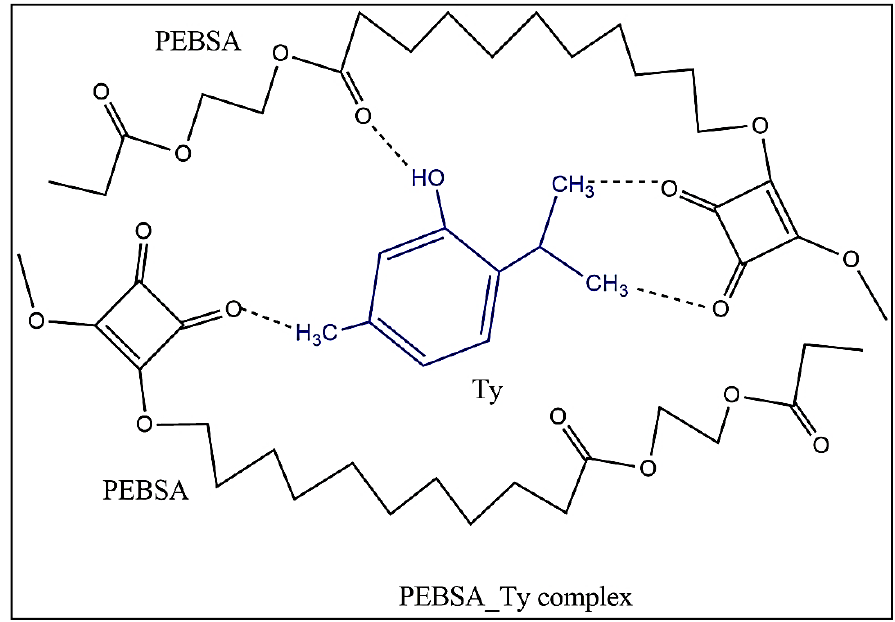
Figure 15. Illustration of PEBSA_Ty bioactive complex formation.